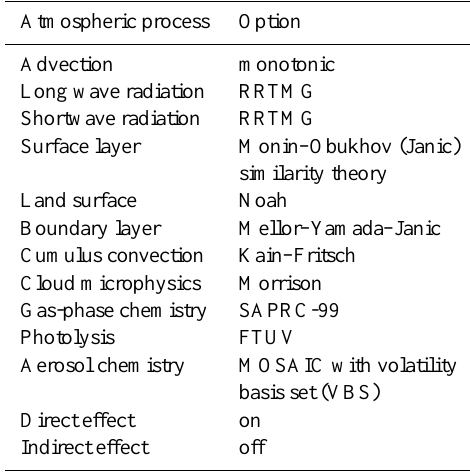
Table 1. Selected WRF-Chem configuration options used for this